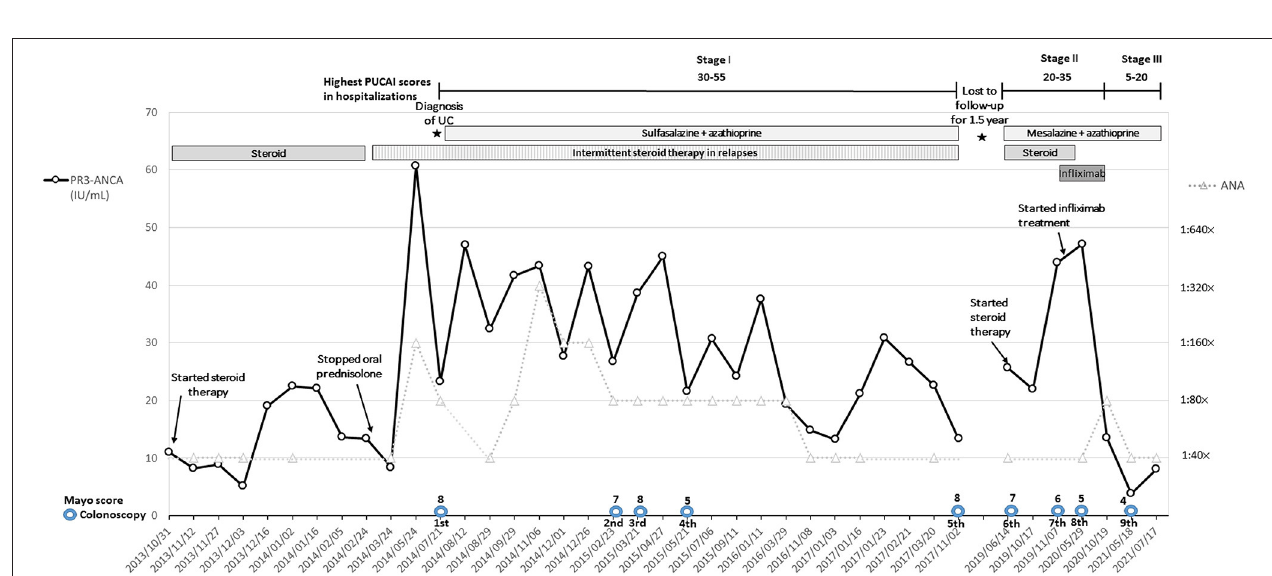
FIGURE 2 | Medical images during third hospitalization of patient with recurrent bilious vomiting. (A) Barium follow-through examination revealed patency in the gastrointestinal tract but segmental dilation at the distal jejunum (arrows), which is compatible with intestinal pseudo-obstruction. CT scan revealed (B) a markedly distended stomach, (C) dilated proximal small intestines with air–fluid levels (arrows) and edematous distal small intestines (arrowheads). Abdominal sonography revealed (D) duodenal dilatation, (E) gastric dilatation, (F) pelvic ascites, and a (G) sharp aortomesenteric angle of 14 ◦ . GB, gallbladder; DU, duodenum; SP, spleen; ST, stomach; UB, urinary bladder; UT, uterus; CX, cervix; RO, right ovary; AS, ascites.